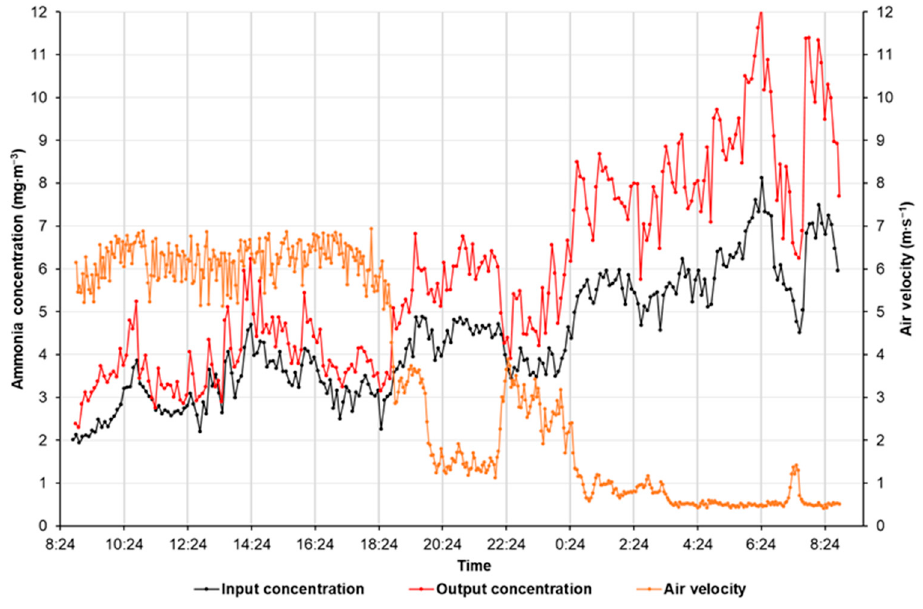
Figure 3. Measured data from experimental pig house. Breakpoints were identified based on the visual evaluation of the course of individual quantities; their values were roughly determined with an accuracy of 0.5 mg · m − 3